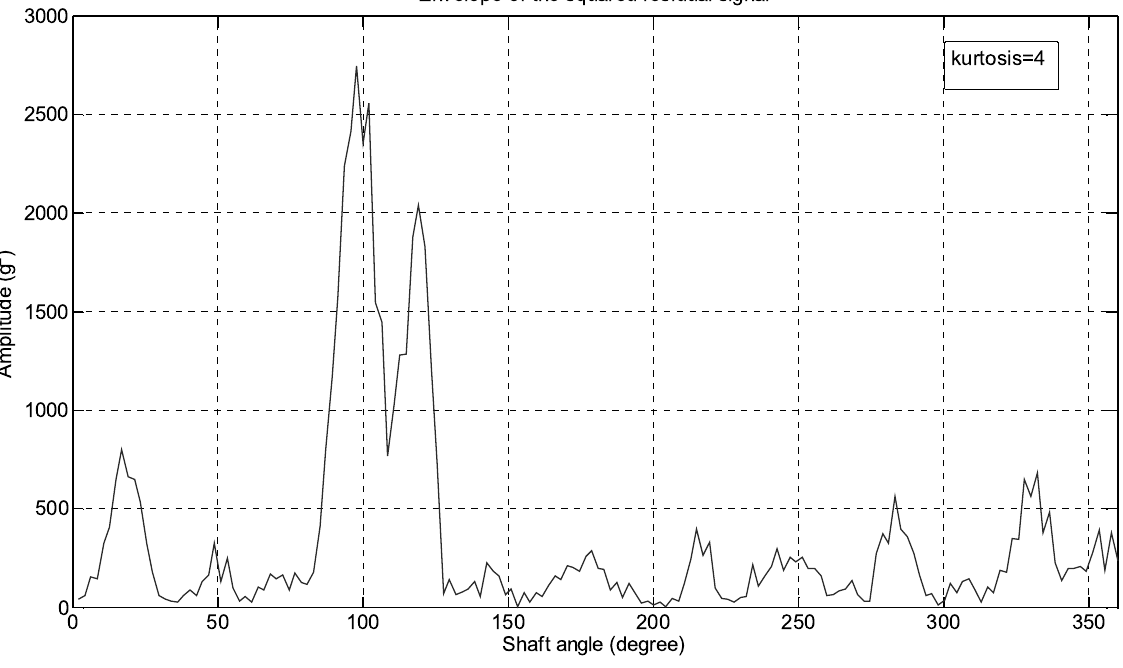
Fig. 16. Envelope of the squared residual signal in the time domain for 5% fault in the 4th harmonic.